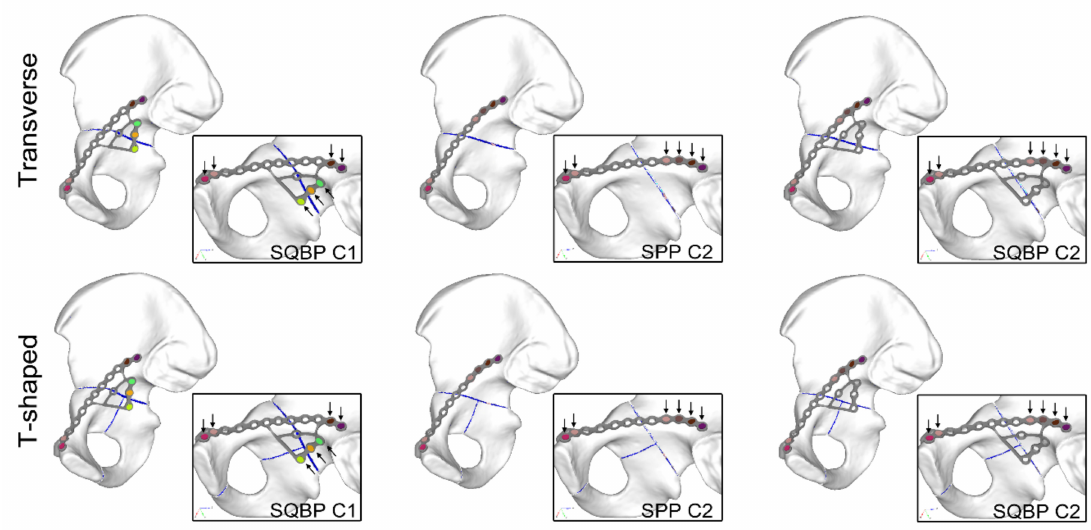
Figure 3. Six implemented models arranged according to plate-screw configuration (on the rows) and fracture typology (on the column). The femoral component simulacrum was here hidden for sake of clarity. The figures inside the black boxes provide a view of the plated region, allowing to focus on the screws configurations (black arrows) and on the implemented